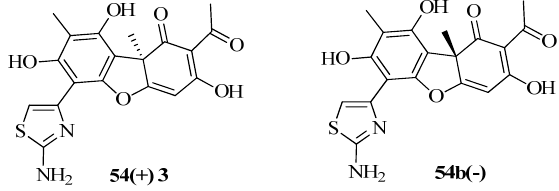
Figure 20. Structures of new usnic acid